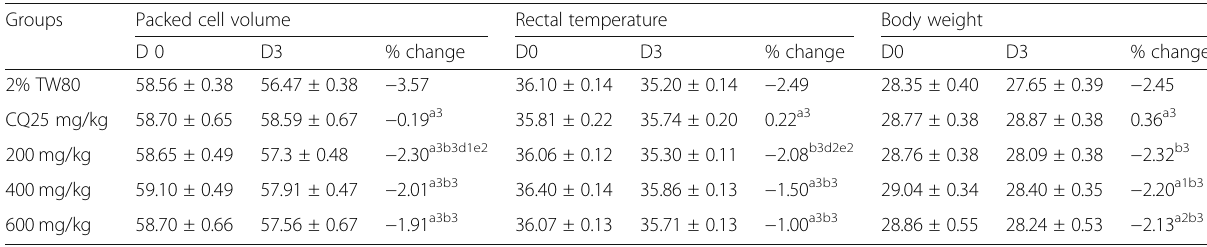
Table 6 Packed cell volume, rectal temperature and body weight of infected mice treated with 80% methanol extract of the leaves of Olea europaea in prophylactic test Groups